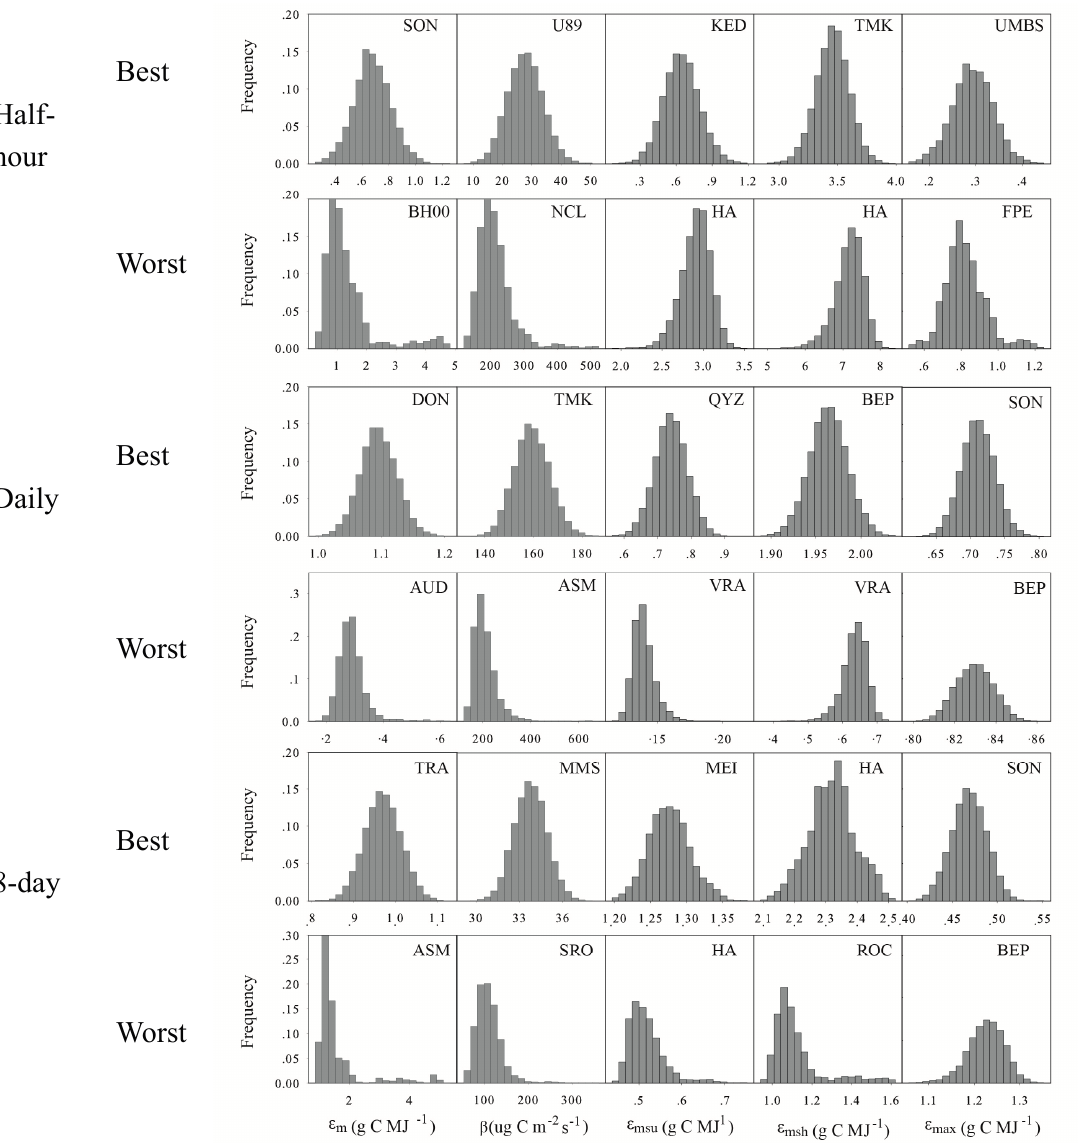
Figure A1. Histograms of the 20000 samples for each parameter generated by the Metropolis-Hasting Algorithm. Note: Only the best and worst cases are shown for each temporal scale owing to space